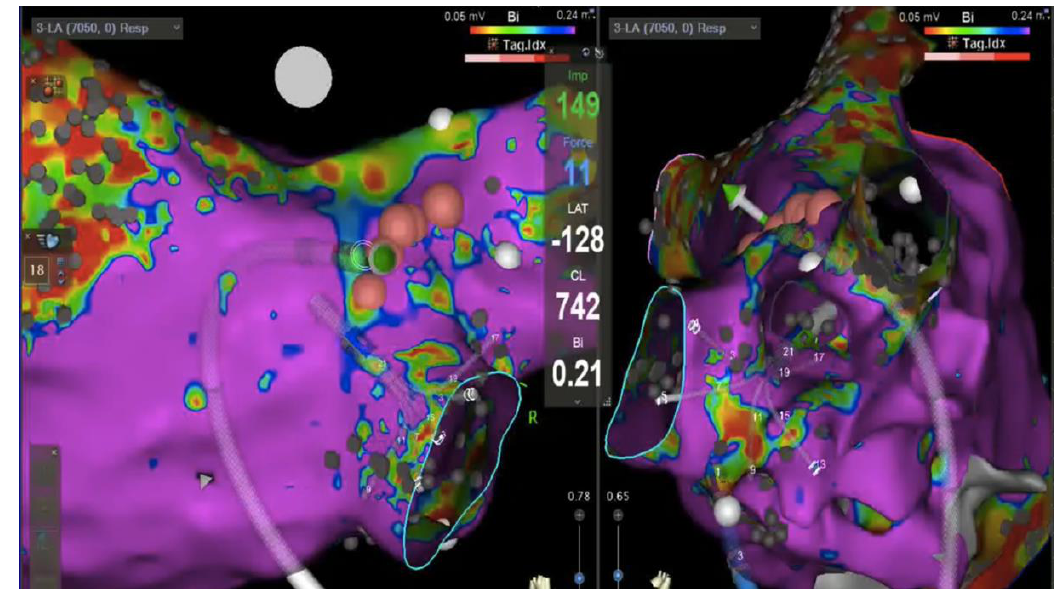
Figure 7. Hybrid imaging: Electoanatomic (Carto v7, Biosense Webster) voltage map of the left atrium (healthy tissue >0.24 mV, in violet); posterior view on the left and right lateral view on the right showing multipolar mapping catheter in the right inferior pulmonary vein antra. The ablation catheter (green vector) is pointing toward the posterior antrum of the vein with a real time 11 g contact force (value reported in light blue in the center of the image). Pink dots represent ablation sites.